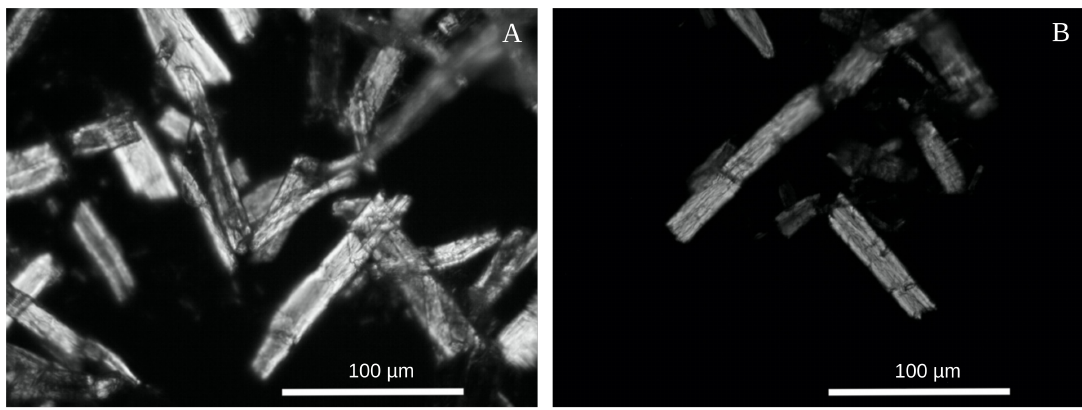
Figure 2. Dark-field micrographs of MCC particles obtained after single ( A ) and double ( B ) hydrolysis and subsequent grinding.